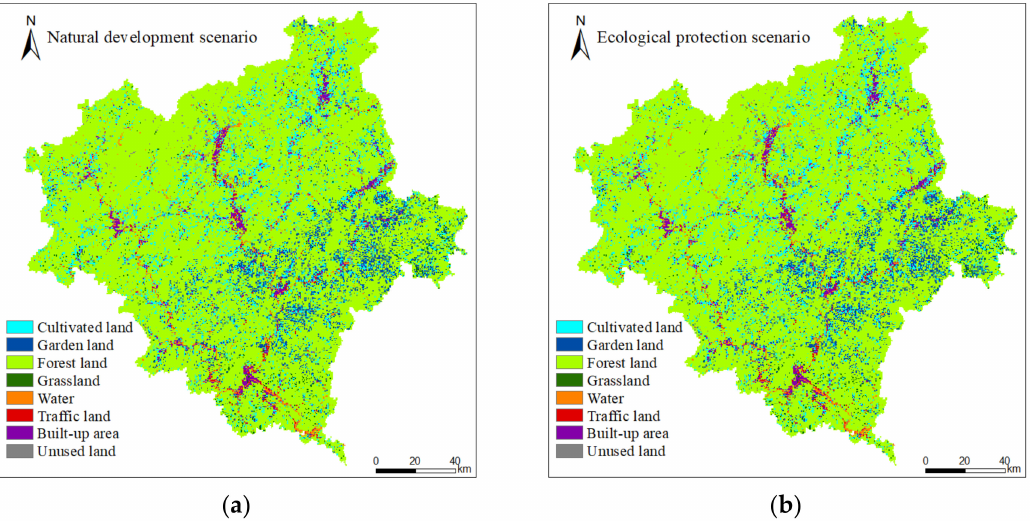
Figure 3. Spatial distribution of land use in 2025 under ( a ) the natural development scenario and ( b ) the ecological protection